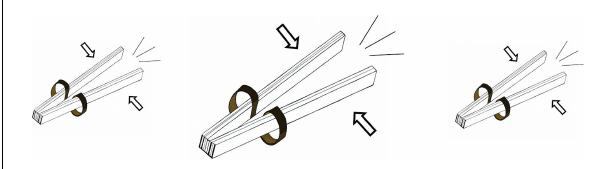
FIGURE 5 | A whip or slapstick. These pictures invite the participant to explore a laminal postalveolar click. By changing the size of the displayed picture, they must react accordingly with volume control. This way, they learn to control the tongue pressure and release in combination with mouth opening in order to influence the volume of the sound. Such helps to practice using the involved articulators, including mainly the